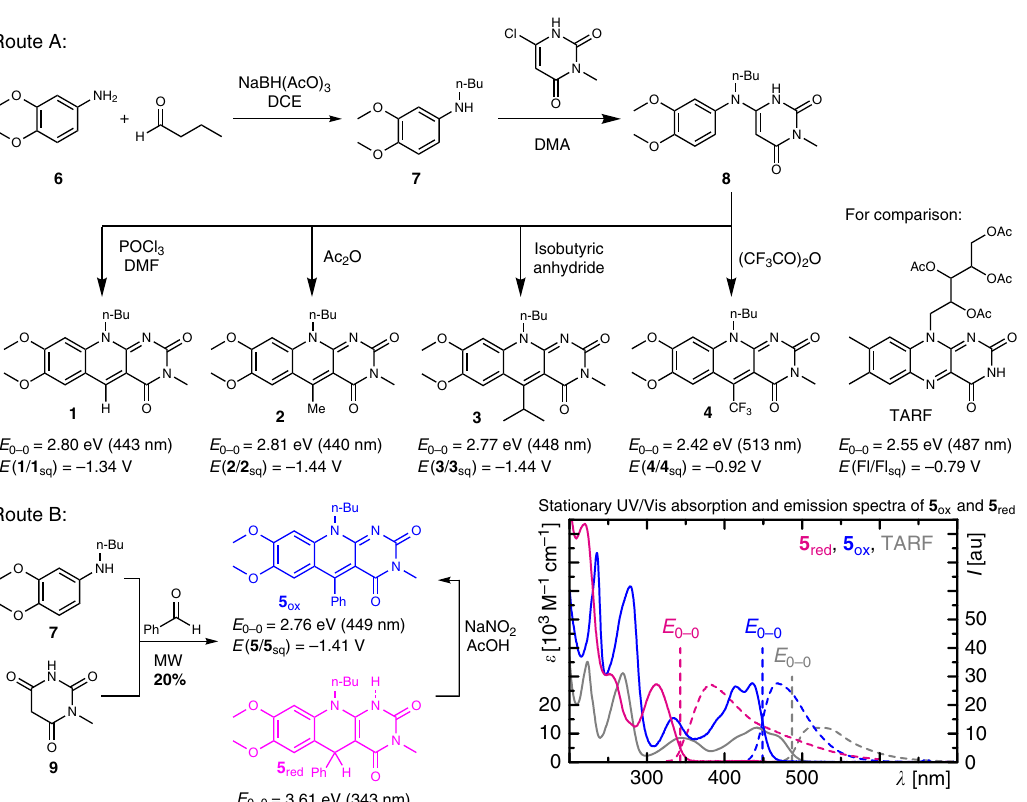
Fig. 2 Synthesis and spectral and electrochemical properties. Electronic transition energies, E 0-0 , and fi rst reduction potentials vs. saturated calomel electrode (SCE) are given for all deaza fl avins. Full spectra are shown for 5 ox and 5 red . Data for tetraacetyl ribo fl avin (TARF) are given for comparison. Further details on synthesis and characterisation are given in Supplementary Notes 1 and 2,